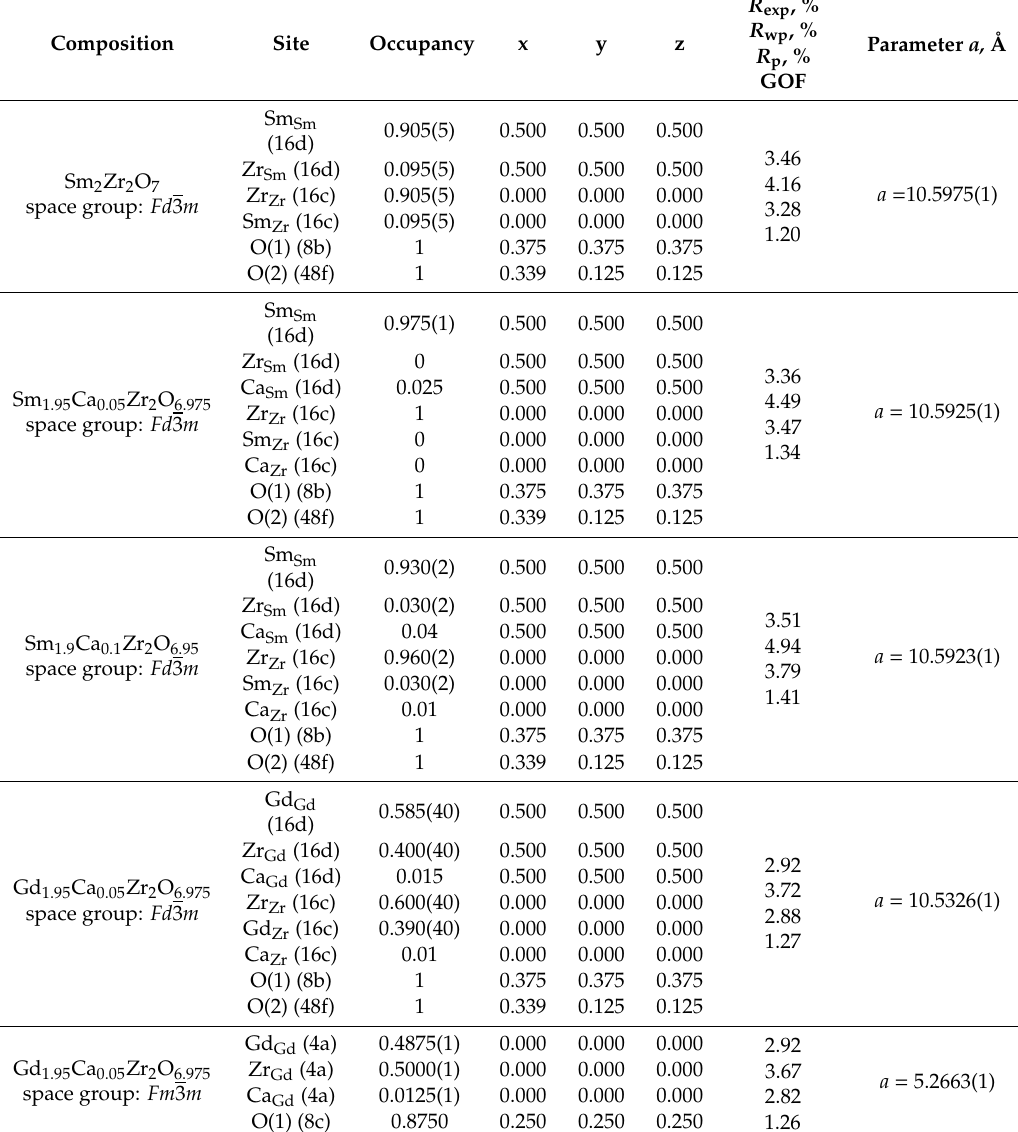
Table 2. Rietveld data for Sm 2 − x Ca x Zr 2 O 7 − x / 2 (x = 0, 0.05, 0.1) and Gd 2 − x Ca x Zr 2 O 7 − x / 2 (x = 0.05, 0.1).